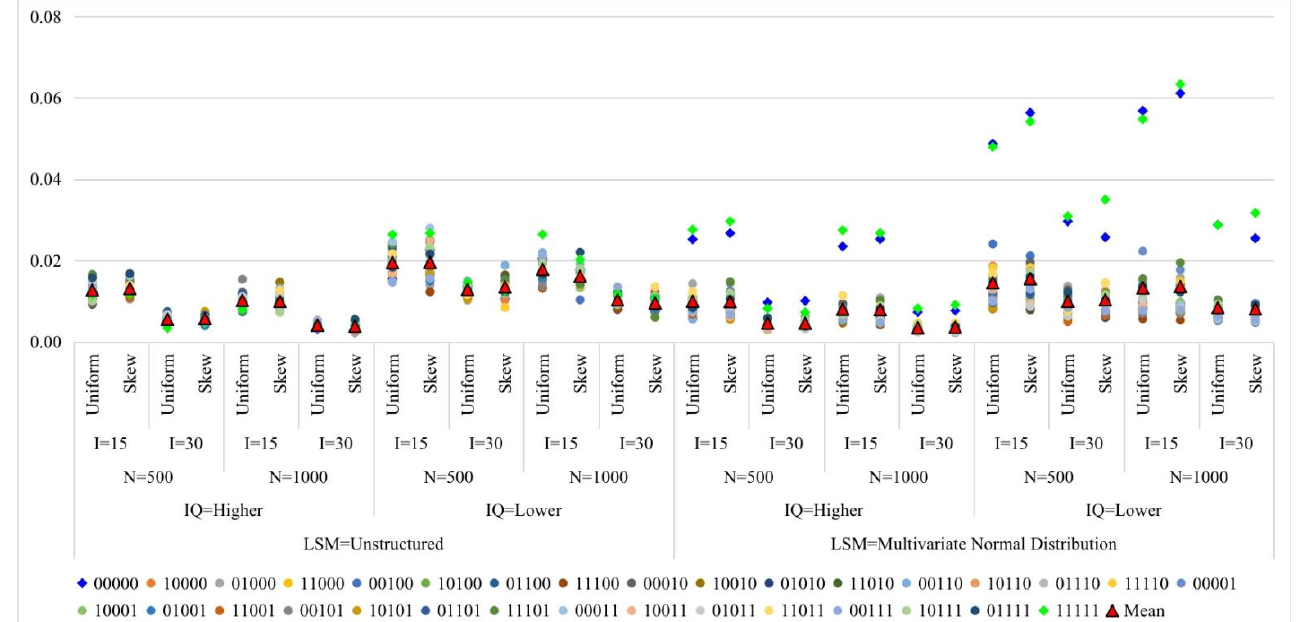
Figure 3. Root mean square error of attribute profile proportions in simulation Study 1. Note: LSM = latent structural model; IQ = item quality; N = sample size; I = test length; Mean = mean of the root mean square errors of 32 attribute profiles.